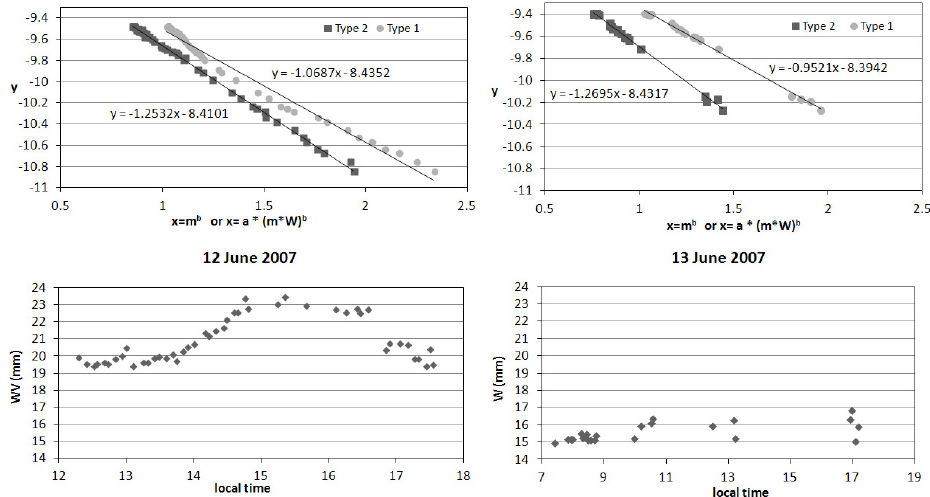
Fig. 2. Water vapour time pattern and application of type-1 and type-2 modified Langley methods for stable (right) and unstable (left) water vapour time pattern cases. A fixed indicative value of b = 0 . 6 (as suggested by Halthore et al., 1997, for narrow band filters) has been assumed.